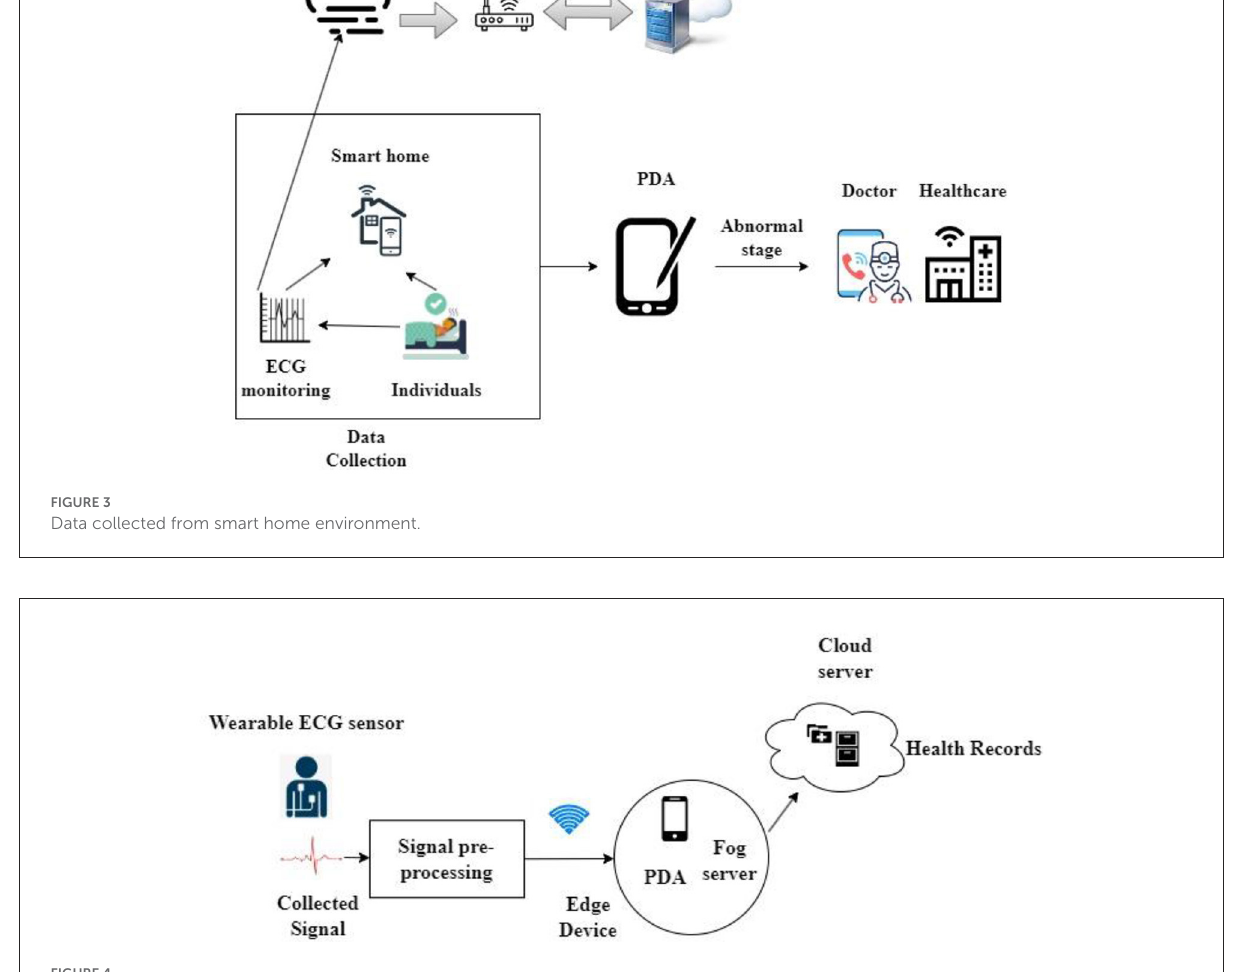
FIGURE4 The stages of data